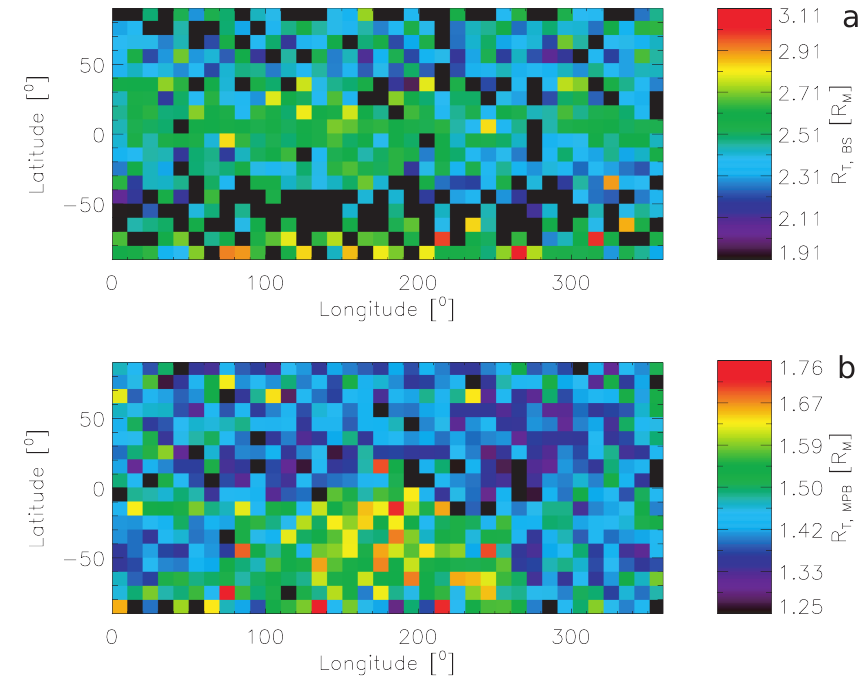
Fig. 8. Longitude-latitude maps colour coded by the extrapolated terminator distance R T of the (a) BS and (b) MPB as observed by MEX. Only dayside crossings were used. Black bins means that there were less than two crossings in that